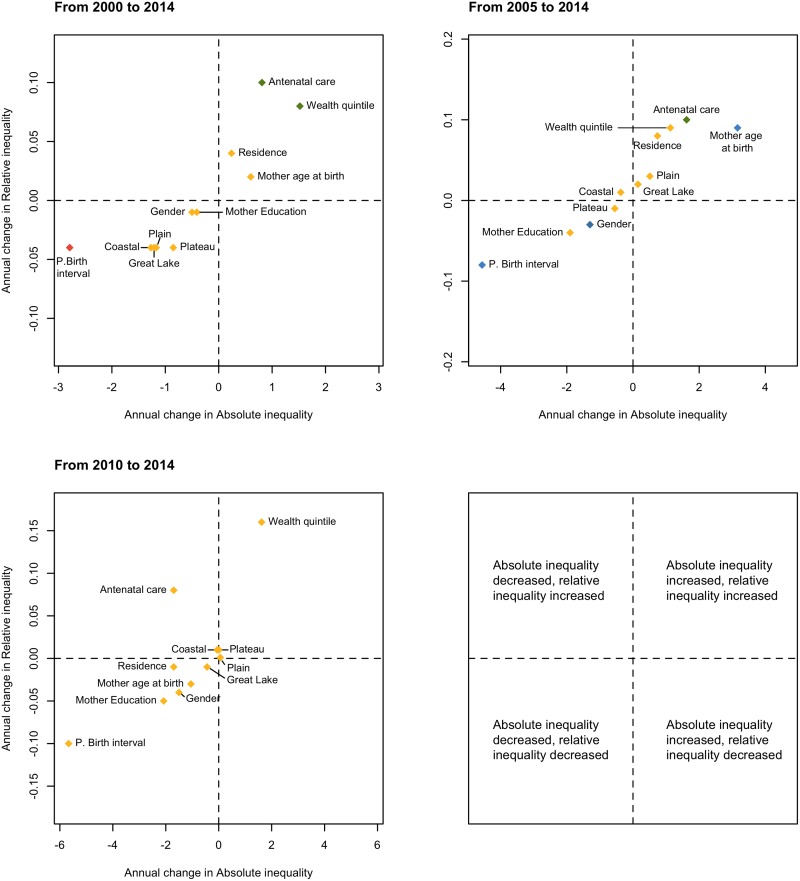
The association between mean annual changes in adjusted relative and absolute socio-economic inequities in meonatal mortality, Cambodia (2000–2014).(red) 95% CI excludes 0 for change in both SII and RII. (yellow) 95% CI includes 0 for change in both SII and RII. (green) 95% CI excludes 0 for change in RII only. (blue) 95% CI excludes 0 for change in SII only.